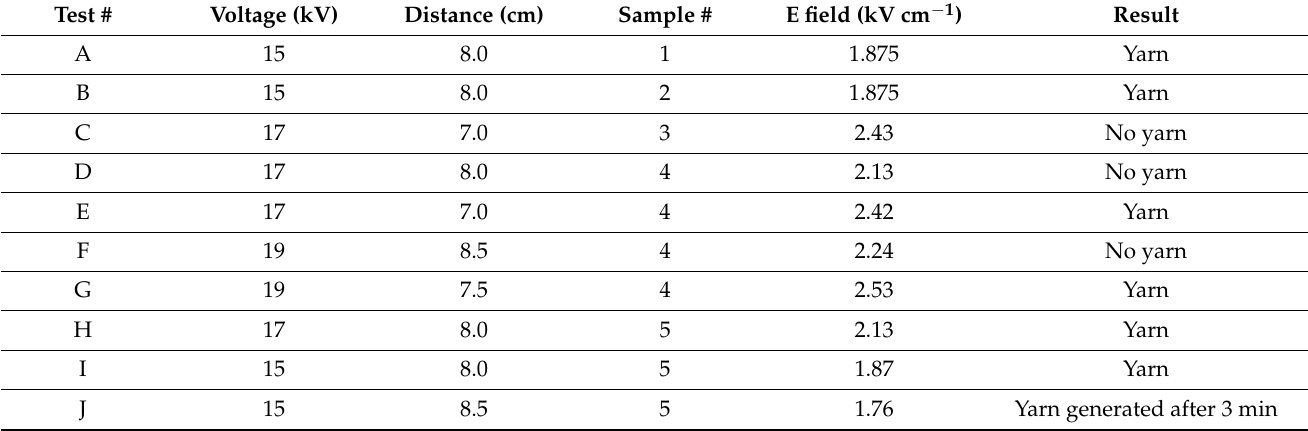
Table 2. Yarn formation due to distance (needle to collector), material composition, and field